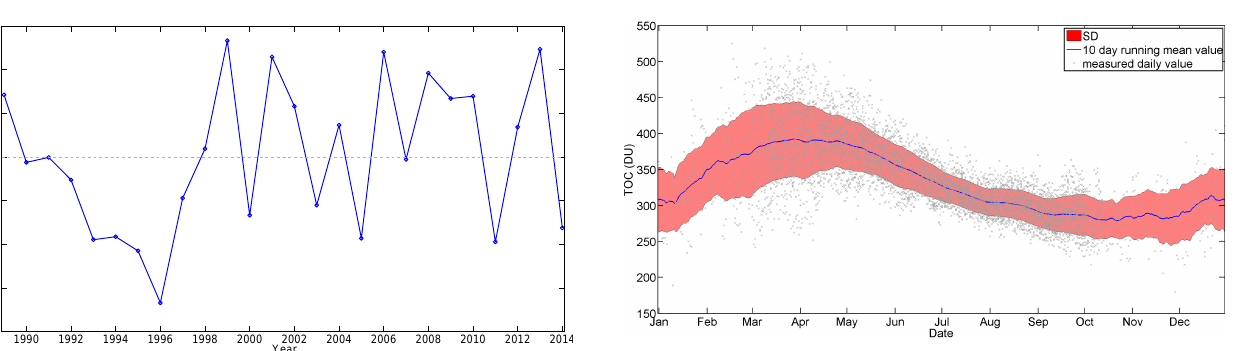
Figure 3. The difference of March monthly mean each year to the all-time March mean.